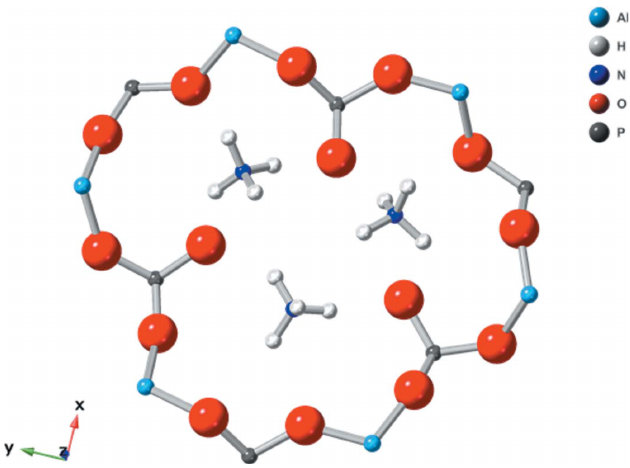
Figure 2 Ball and stick representation of (NH 4 ) 3 Al 2 (PO 4 ) 3 showing the 12- membered ring with three phosphate groups protruding inward with close contact to ammonium cations.